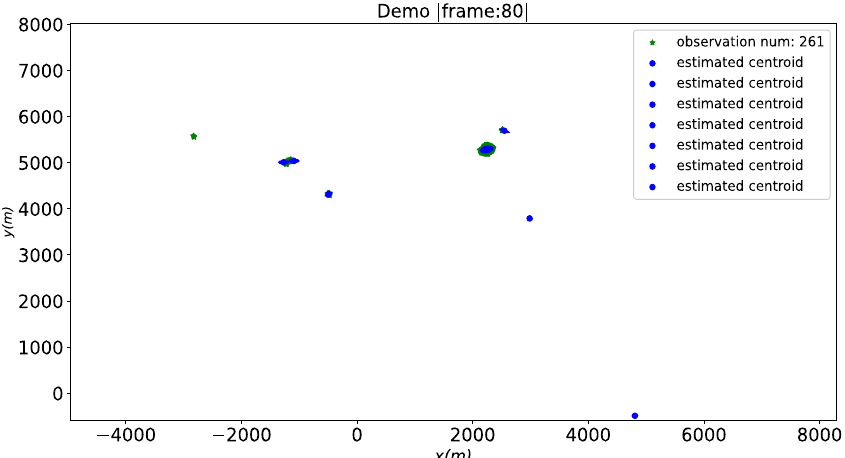
Figure 23. Multi-target tracking in the Cartesian coordinate system in the 80th frame.